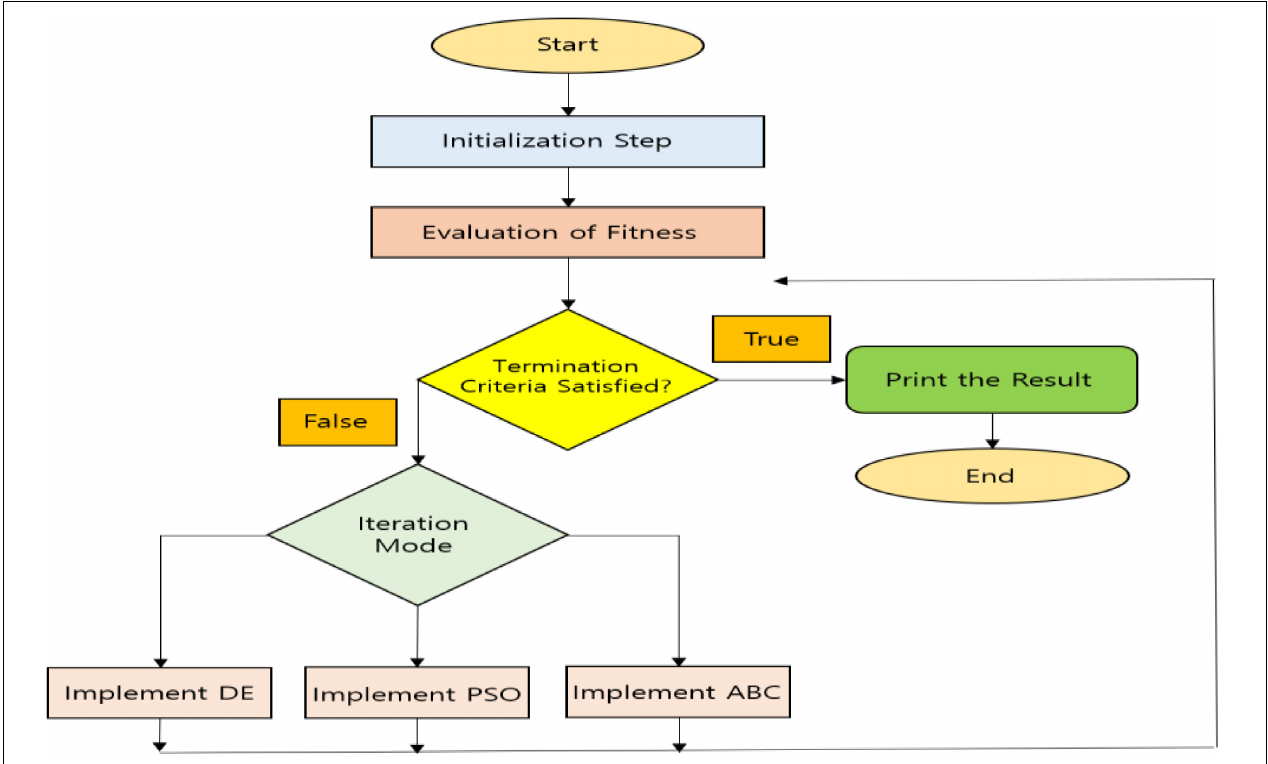
FIGURE 2 | Pictorial representation of Hybrid Differential Particle Artificial Bee (HDPAB).